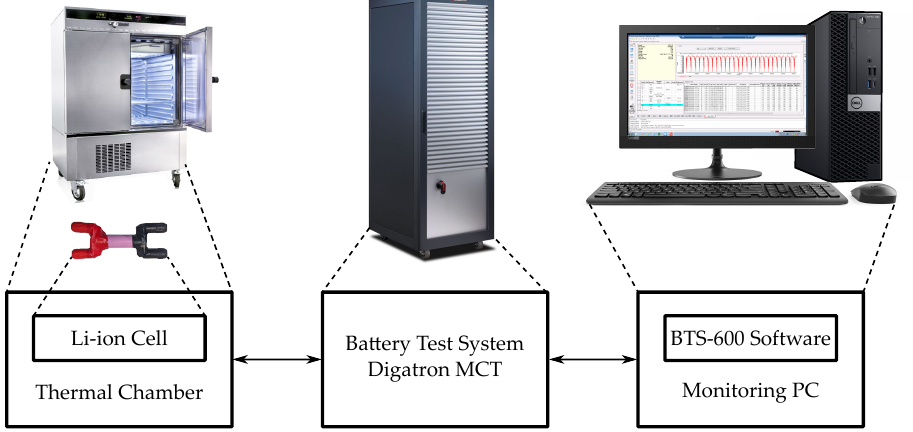
Figure 1. Battery test